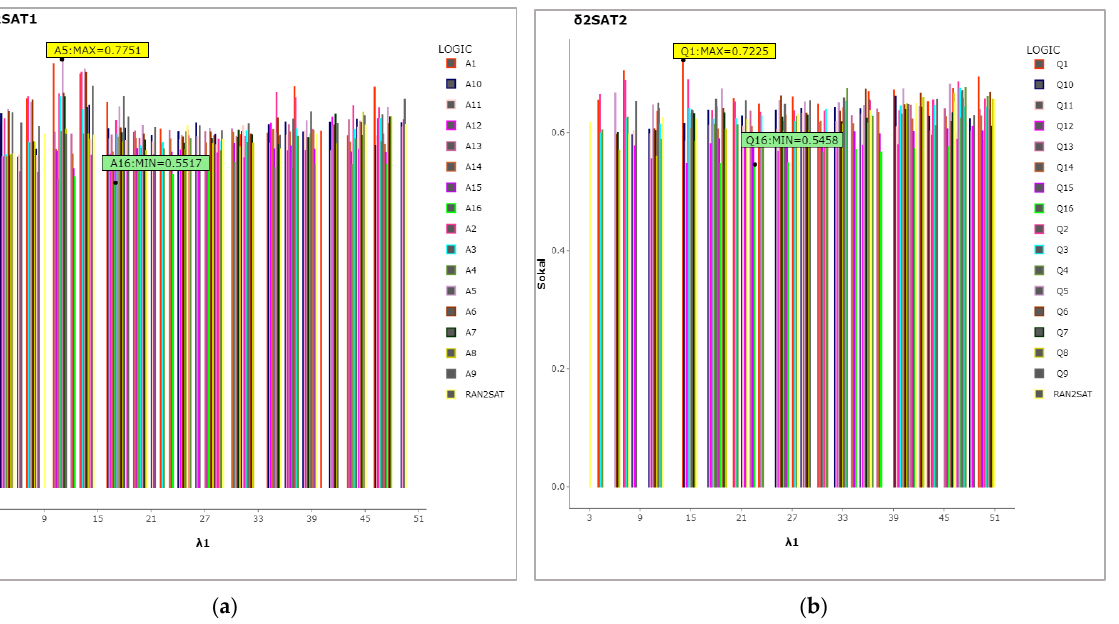
Figure 12. Sokal column representation for models in both types of logic ( a ) δ 1 2 SAT ρ , ( b ) δ 2 2 SAT ρ and RAN2SAT.